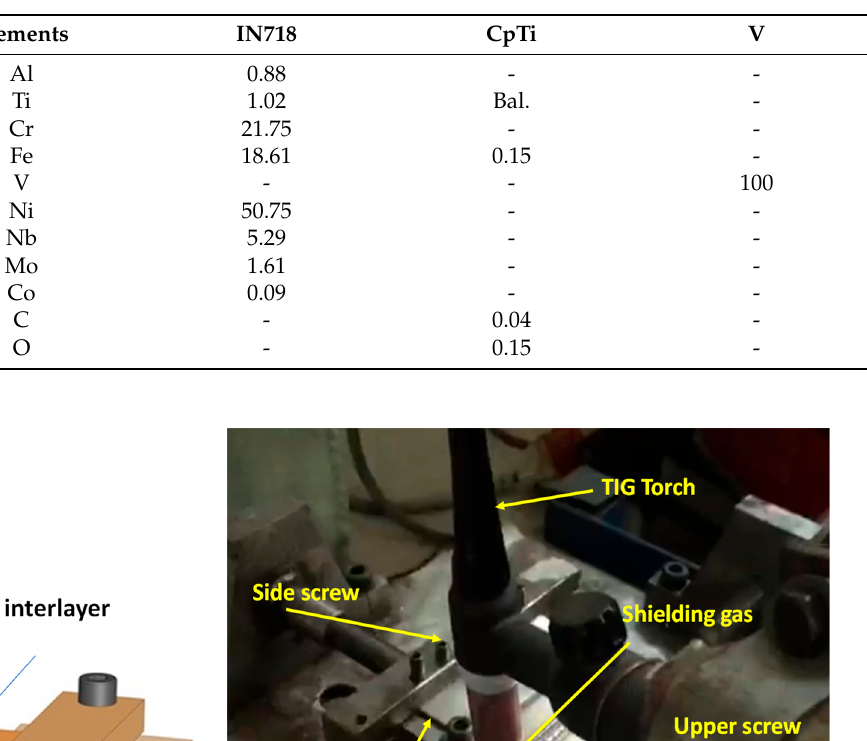
Table 1. Chemical composition (at.%) of IN718, CpTi, and V as measured by EDS.